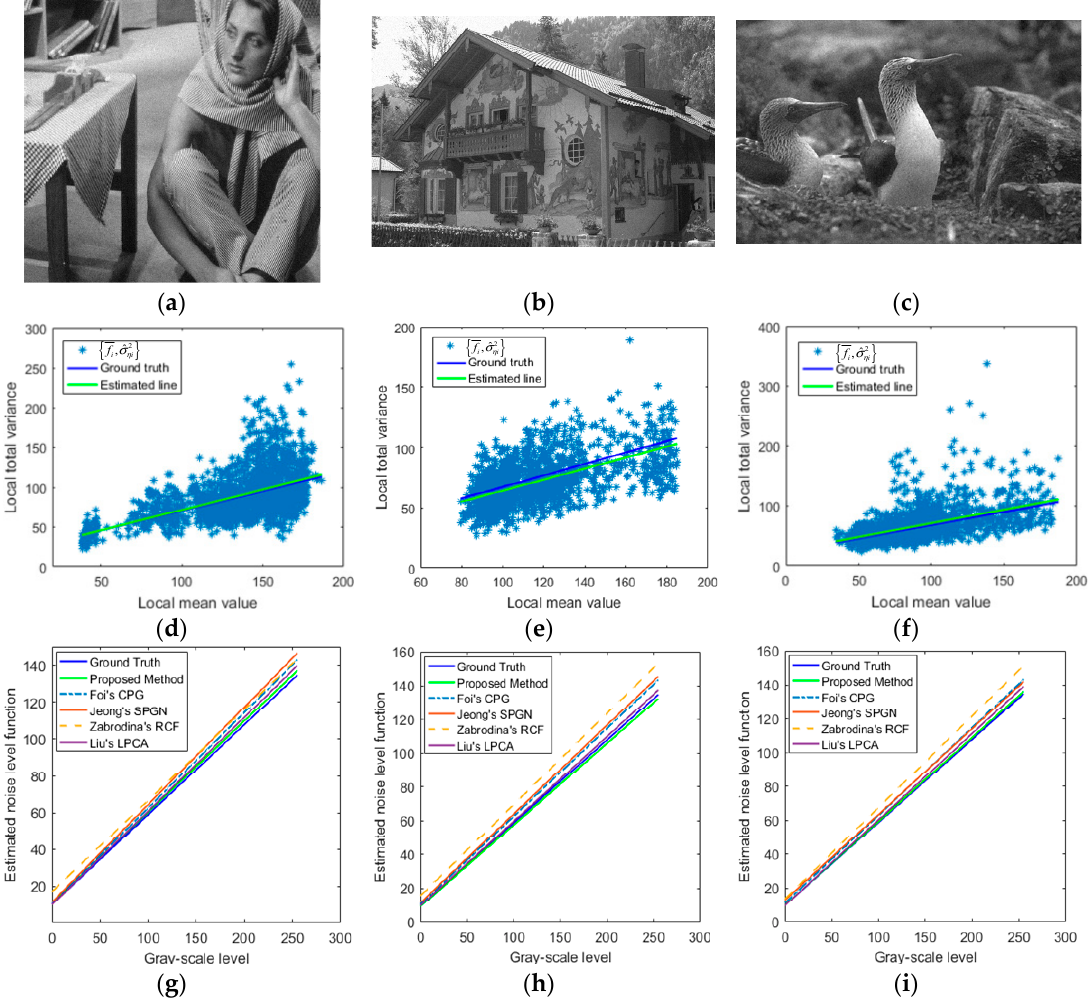
Figure 10. Different Poisson-Gaussian noise (PGN) level estimation methods on three images, and the proposed method out-performs several existing PGN estimation methods. ( a – c ) are noisy images (“Barbara,” “House,” “Birds”) with ρ = 0.5 and σ 2 n = 10; ( d – f ) are the results of our parameter estimation algorithm respectively; ( g – i ) are the results of different PGN estimation methods respectively.